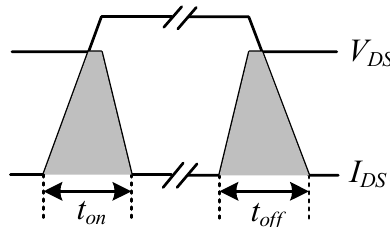
Figure 7. Power loss of MOSFET under switching.